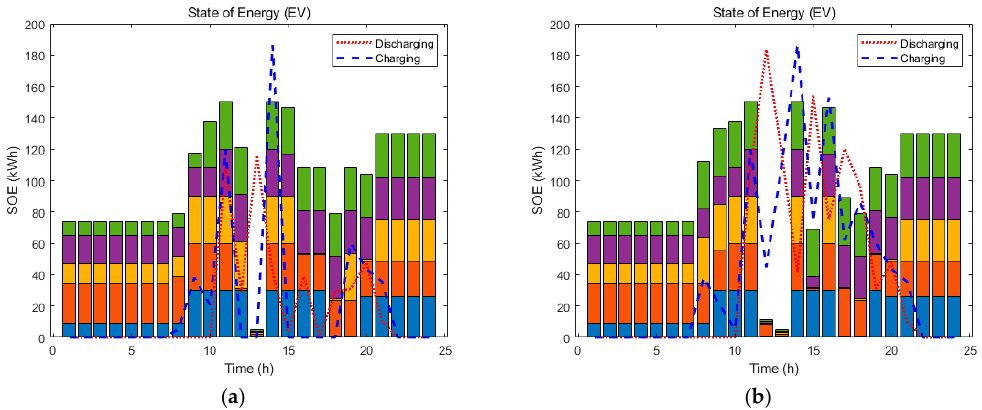
Figure 8. Optimal SOE of EV scheduling results in summer: ( a ) Without DR; ( b ) with DR.